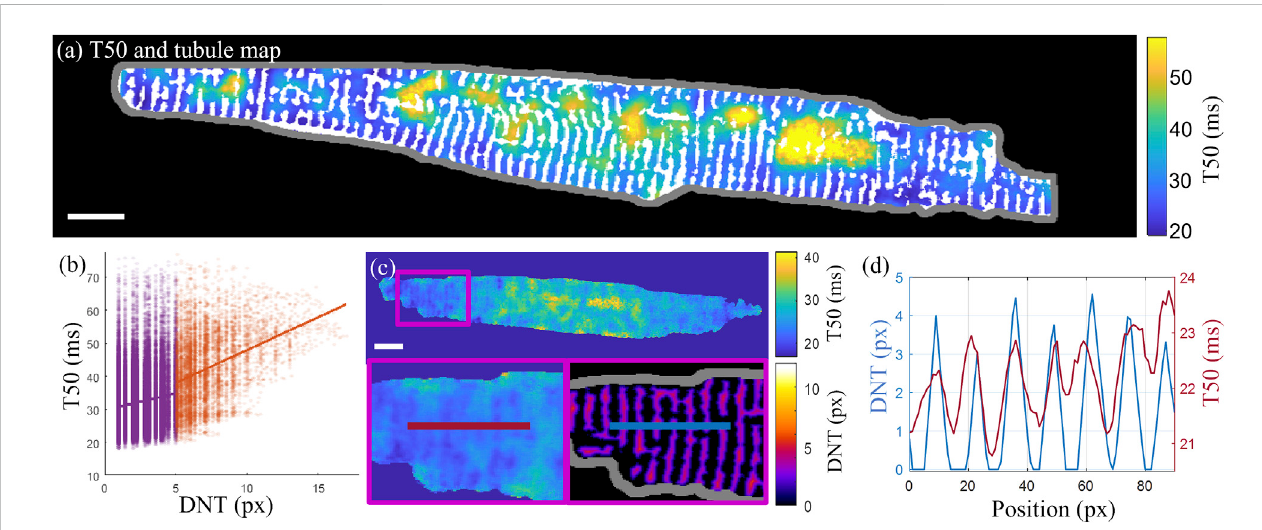
FIGURE 6 Correlation of the t-tubule structure with transient time-to-half-maximum (A) Time-to-half-maximum (T50, in ms) map for the T50 average over three consecutive transients of cell D with binary t-tubules overlaid inwhite. (B) T50 correlation with DNT across all pixels in cell (D) . Linear fi tsto tubulated (purple) and detubulated (orange) regions have slopes of 0.99 ms/px, 95% CI [0.94 1.04], and 1.99 ms/px, 95% CI [1.89 2.08], indicating increased positive correlation ofT50withDNTindetubulatedregions. (C) Horizontallinepro fi les(averagedverticallyovera5-pixelwidth)takenthroughtheT50(leftandtop)andDNT (bottomright) mapsofcellC. (D) Thelinepro fi lesthroughT50 andDNTmapsshown inpanel (C) areoverlaid, indicating earliertransient riseinareascloserto tubules. Scalebar: 10